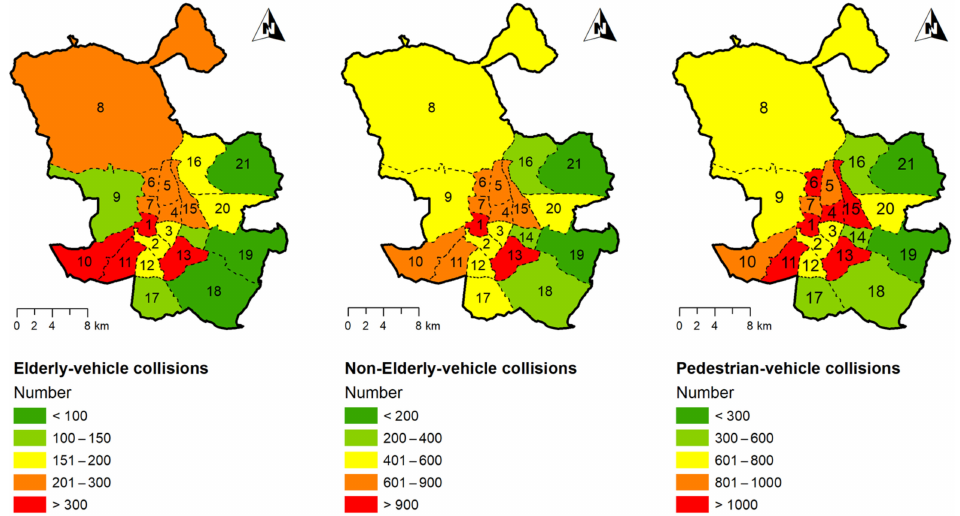
Figure 2. Number of collisions suffered by elderly pedestrians, non-elderly pedestrians, and all pedestrians per Madrid district for the period